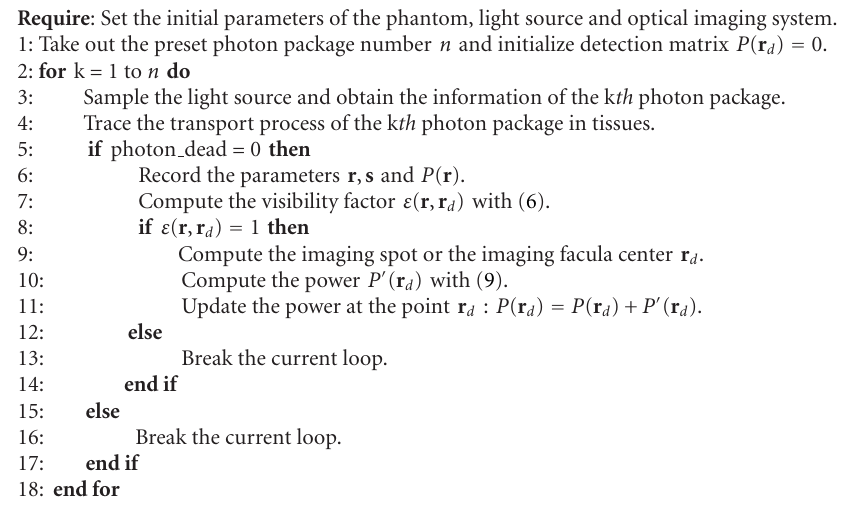
Algorithm 1: Uniform framework for MC-based photon transport